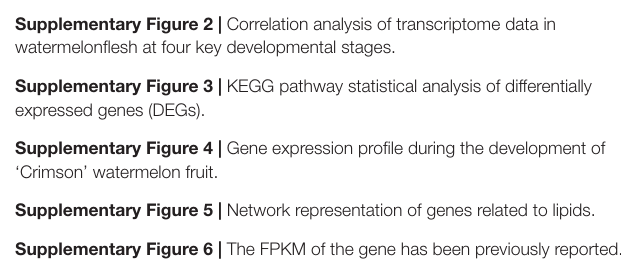
Supplementary Figure 1 | Hierarchical clustering analysis of all 443 metabolites. Supplementary Figure 2 | Correlation analysis of transcriptome data in watermelonflesh at four key developmental stages. Supplementary Figure 3 | KEGG pathway statistical analysis of differentially expressed genes (DEGs). Supplementary Figure 4 | Gene expression profile during the development of ‘Crimson’ watermelon fruit. Supplementary Figure 5 | Network representation of genes related to lipids. Supplementary Figure 6 | The FPKM of the gene has been previously reported. Supplementary Table 1 | The relative expression of 443 metabolites detected by UPLC-ESI-MS/MS of 12 samples. Supplementary Table 2 | The information of differential accumulation of metabolites detected by UPLC-ESI-MS/MS. Supplementary Table 3 | Relative expression levels of volatile organic compounds in 12 samples. Supplementary Table 4 | Differential expression of volatile organic compounds at four development stages. Supplementary Table 5 | The FPKM value of the gene was found in 12 samples. Supplementary Table 6 | The Pearson correlation coefficient between lipidS and